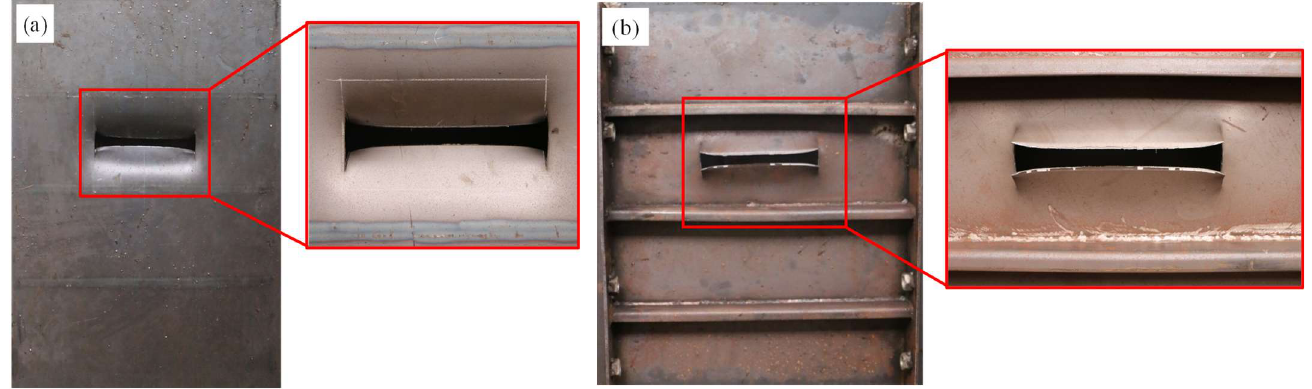
Figure 13. Deformation of the conventional plate under eccentric impact: ( a ) front side; ( b ) back side.